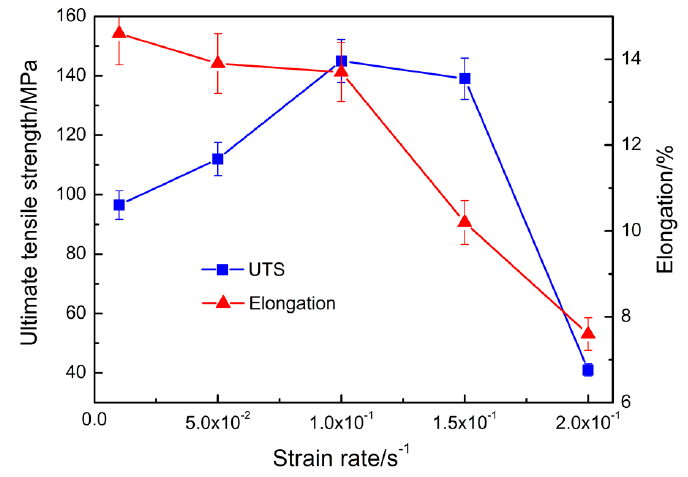
Figure 6. The variations in tensile properties of the thixoforged composite tensile tested at 200 °C under different initial strain rates.